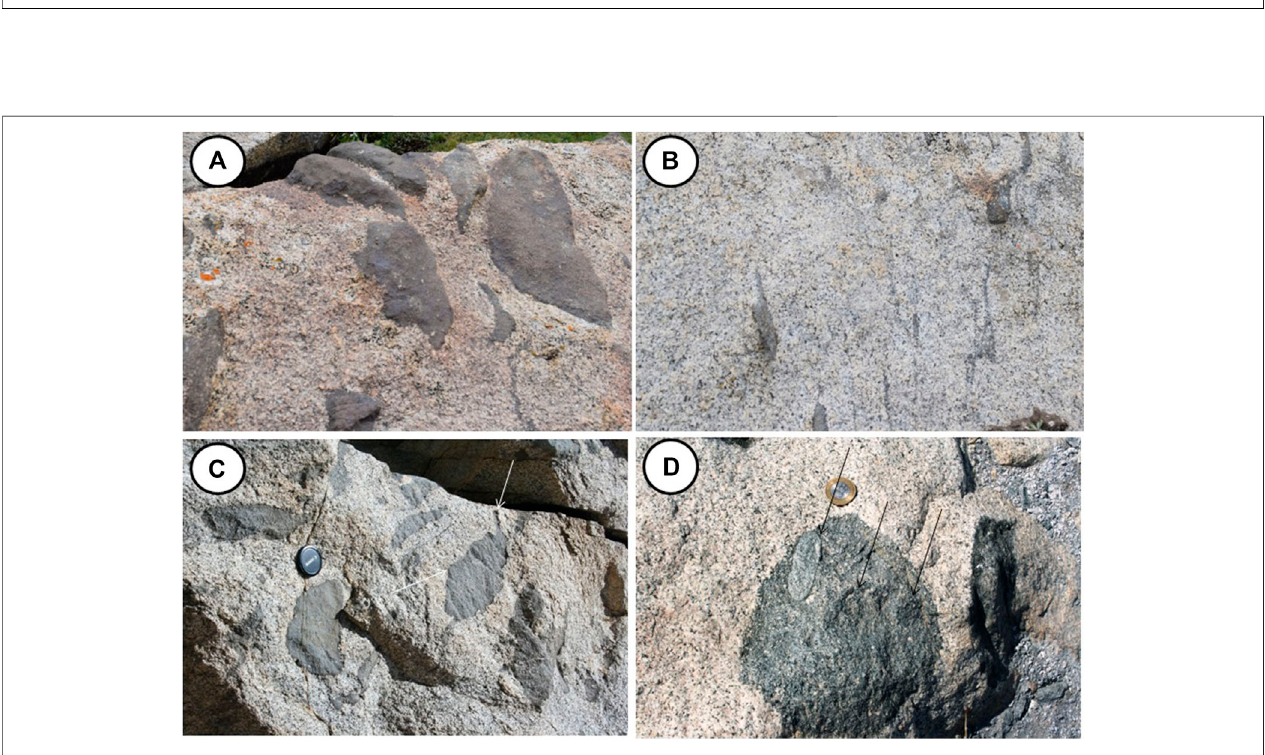
FIGURE 4 | (A) Ma fi c enclaves with variable shapes and sizes showing the common sharp and occasional cuspate margins. Note the presence of minor ma fi c schlierens. (B) Ma fi c schlierens correlate well with mostly digested enclaves within the host granite. (C) Ma fi c enclaves of variable shapes and sizes. Note an enclave shows viscous fi nger texture and cuspate margin (white arrows). These features of enclaves are from a large part of outcrop as shown in Kumar (2010a). (D) A nearly circular composite enclave encloses circular melanocratic to elongate mesocratic enclaves (shown by black arrows).